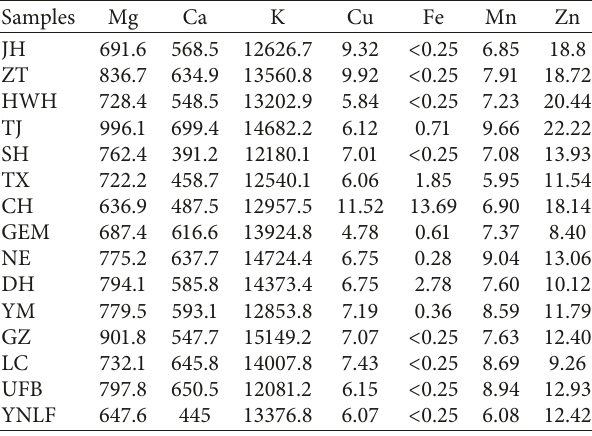
Table 3: Content of mineral elements in goji berries (mg/kg). Samples